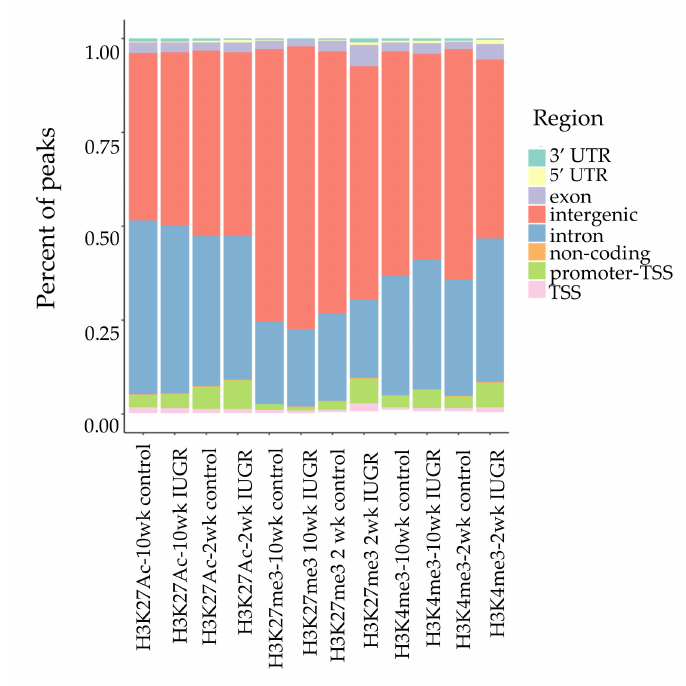
Figure 2. Genomic locations of histone modifications. Bars represent the location and proportion of each histone mark, TSS defined as 100 bp upstream to 1 kb downstream of TSS. Promoter-TSS is 1 kb upstream to 100 bp downstream of TSS. 5 ′ untranslated region (5 ‘UTR) starts at TTS and ends before the initiation codon. 3 ′ UTR starts immediately following termination codon. Non-coding regions are non-encoding protein sequences. Intergenic regions represent regions beyond the above defined regions.